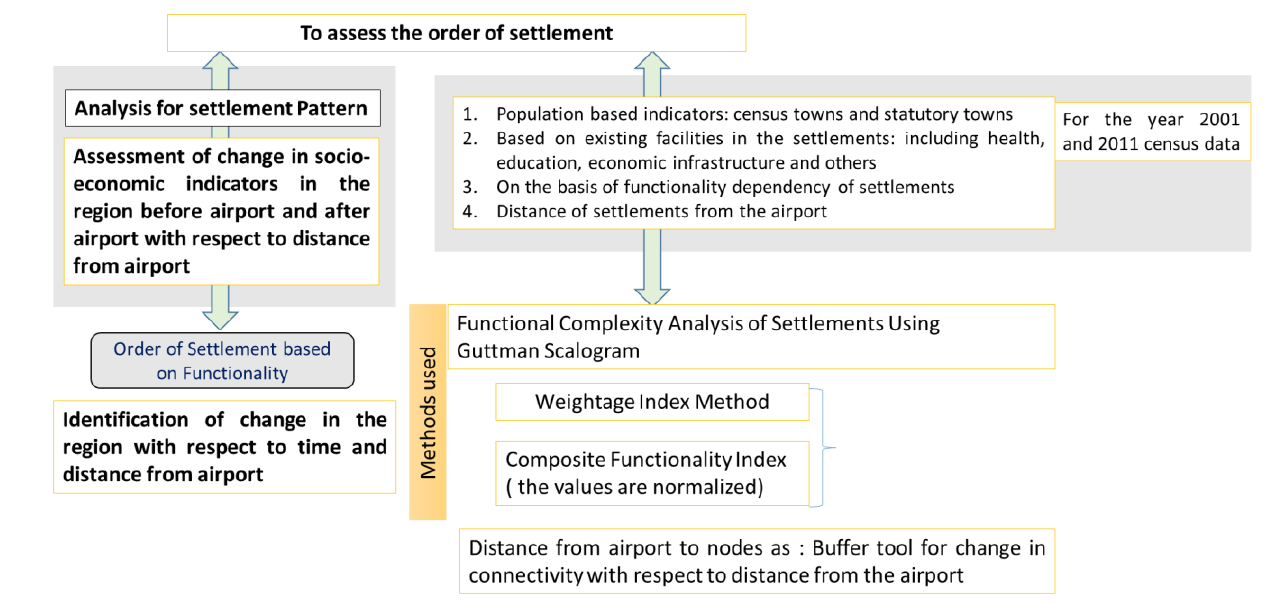
Figure 6. Calculation of composite functionality index .